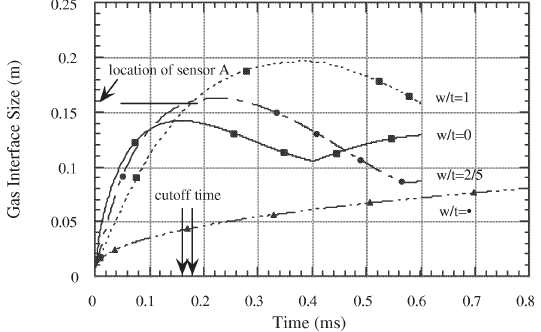
Fig. 5. Interface growth between the gas products and air, A is the closest location of sensor.